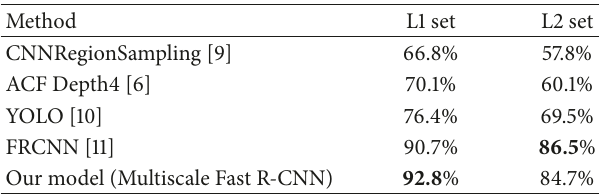
Table 3: Average Precision (AP) on VIVA L1 and L2 dataset and comparison with previous